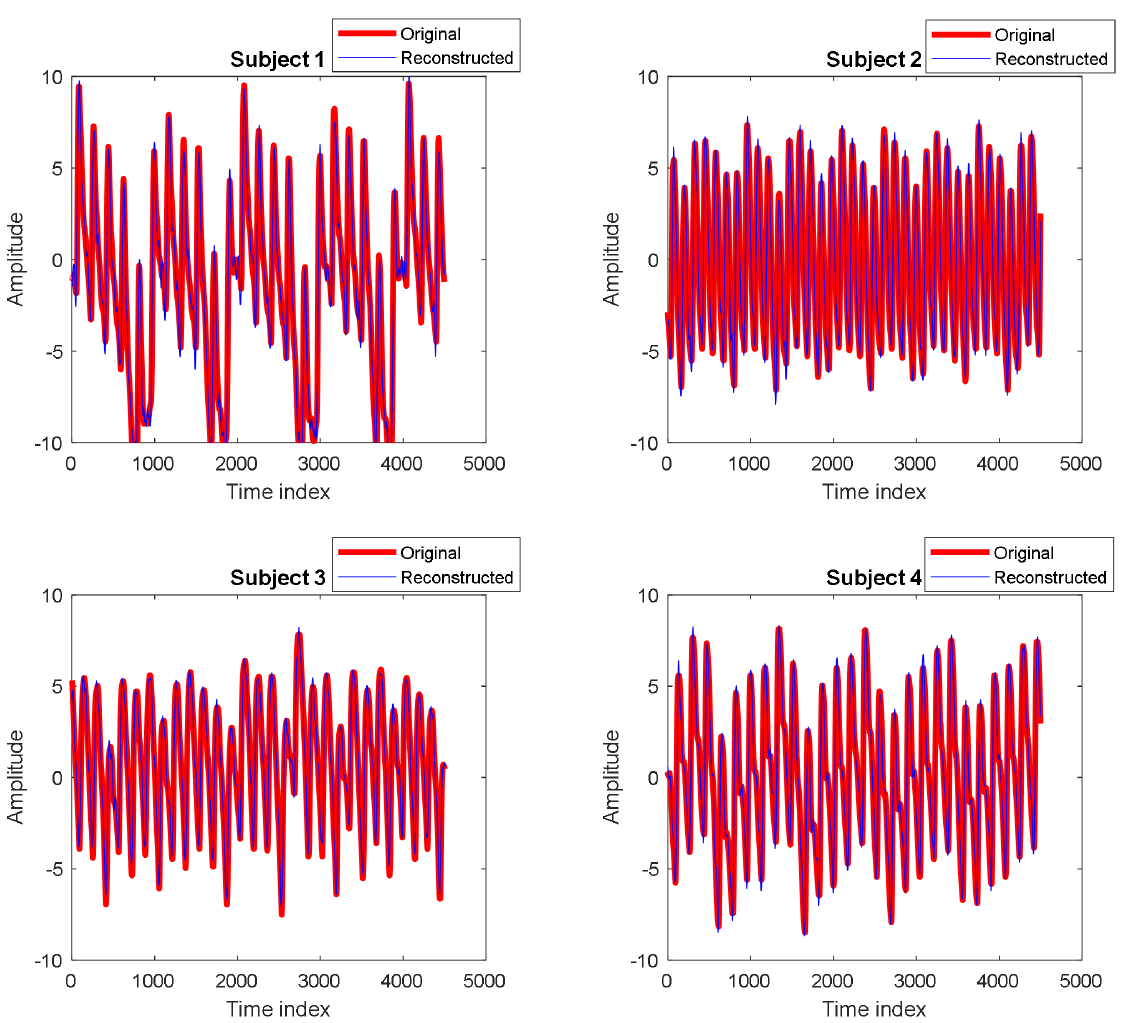
Figure 7. Examples of original and reconstructed signals of four different